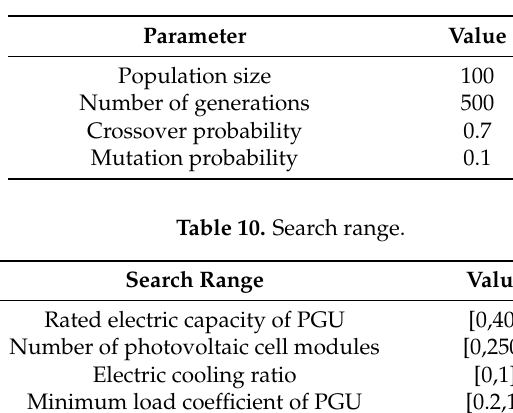
Table 9. GA parameters.